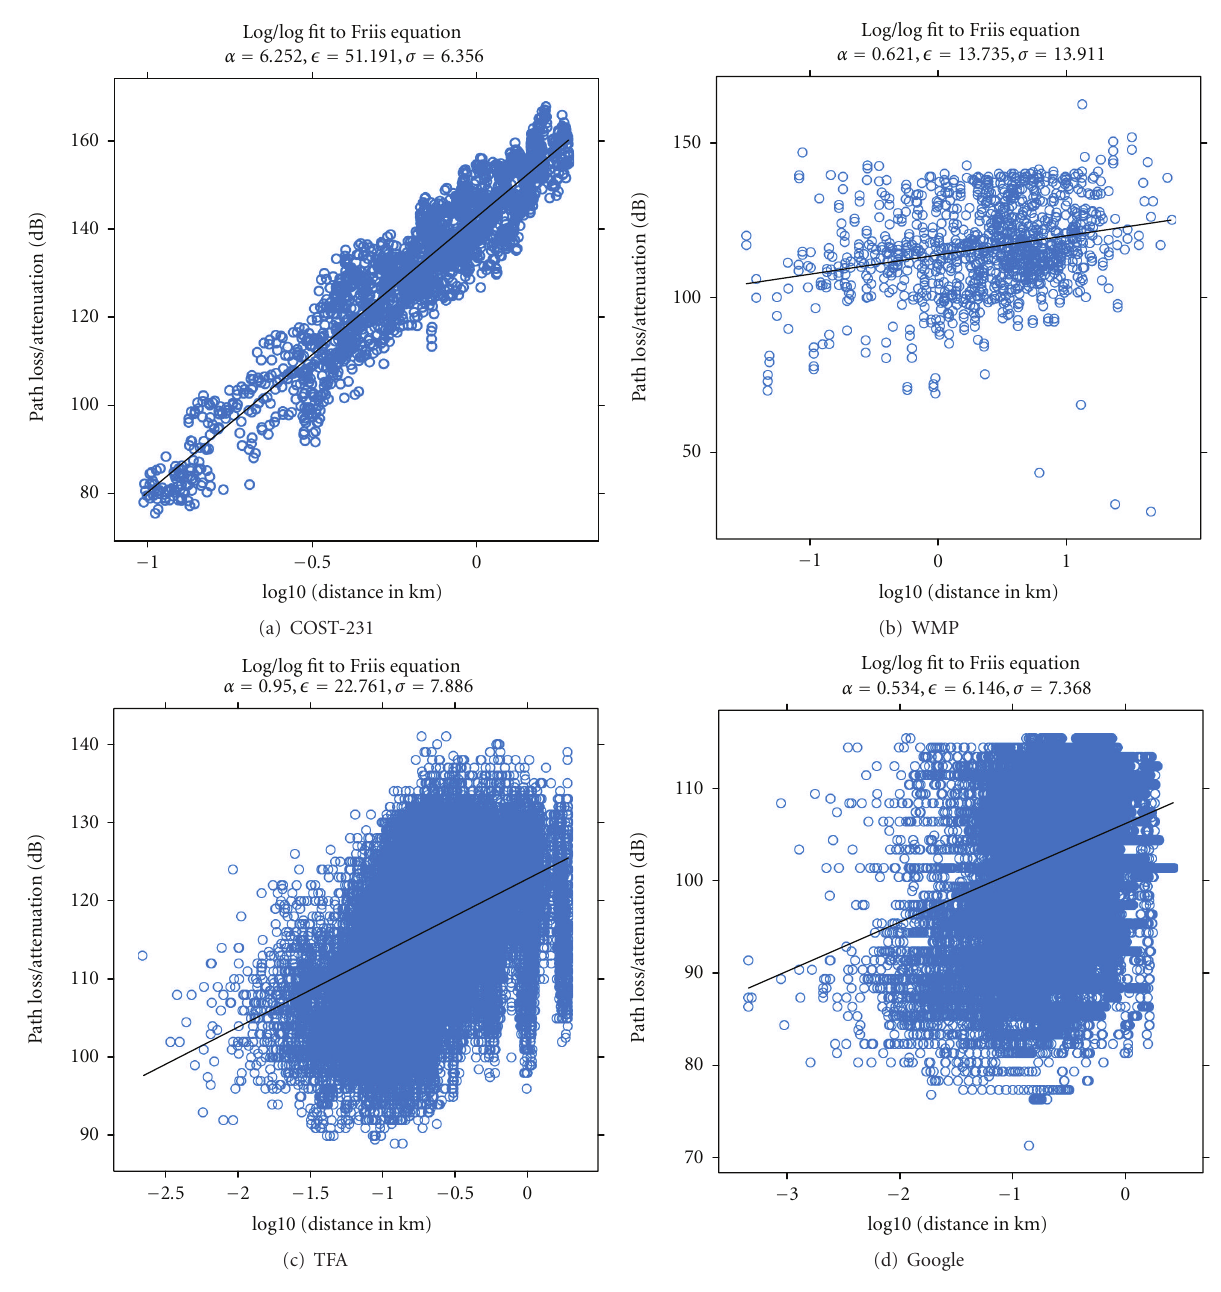
Figure 7: Explicit power law fits to data. Fit parameters are provided on the